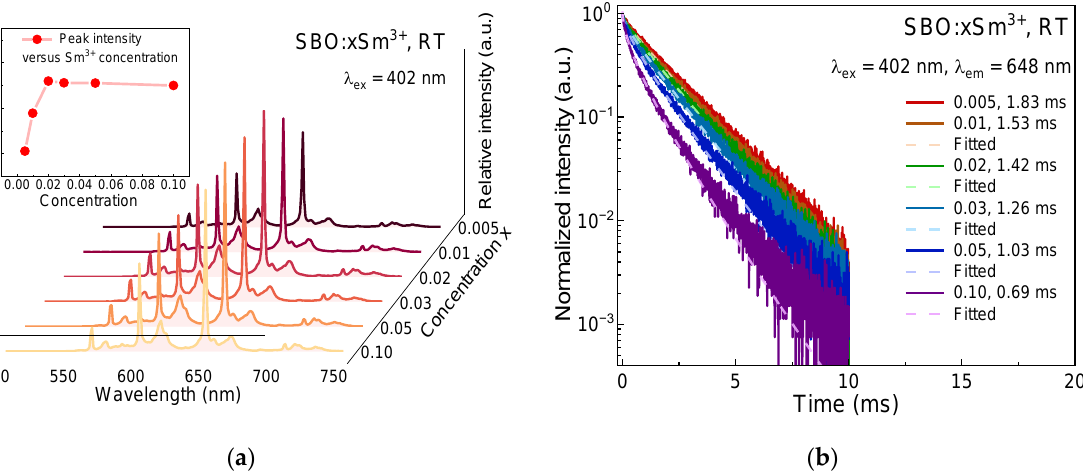
Figure 3. ( a ) Concentration-dependent emission spectra (λ ex = 402 nm) of SBO:0.005Sm 3+ at RT, the inset shows the peak intensity at 648 nm as a function of doping concentration; ( b ) The corresponding concentration-dependent decay curves (λ ex = 402 nm, λ em = 648 nm) and fitted results via Inokuti-Hirayama (I-H) model of SBO:xSm 3+ (x = 0.005, 0.01, 0.02, 0.03, 0.05, 0.10) at RT.